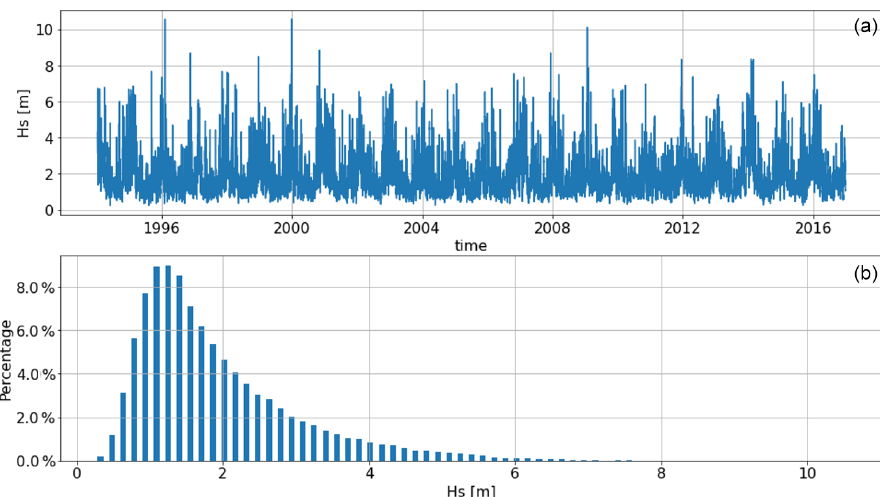
Figure 4. A 3h time series (a) and the histogram of H s (b) at node no. 7818. Results were obtained using the HOMERE dataset.